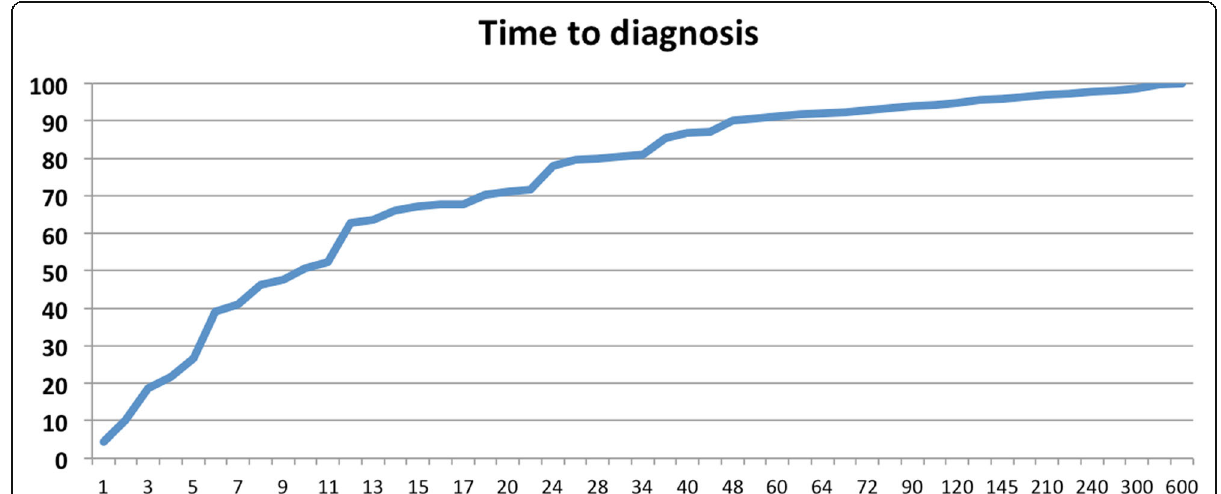
Fig. 1 Time to diagnosis. Percentage of patients that have been diagnosed at each given point (y-axis). X-axis represents the time in months to diagnosis